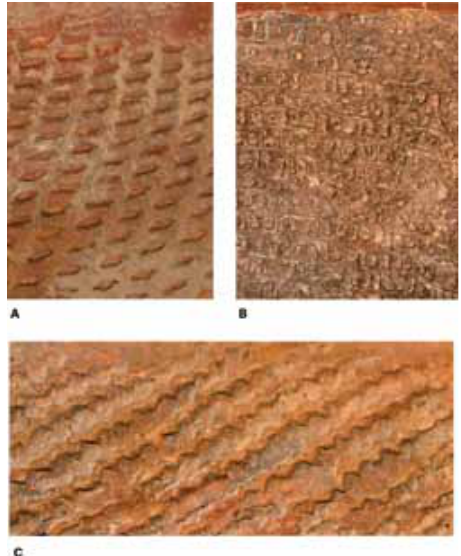
Fig. 8: The three main roulette types of Soro- tomo: (a) folded strip; (b) fish verte- brae; and (c) braided